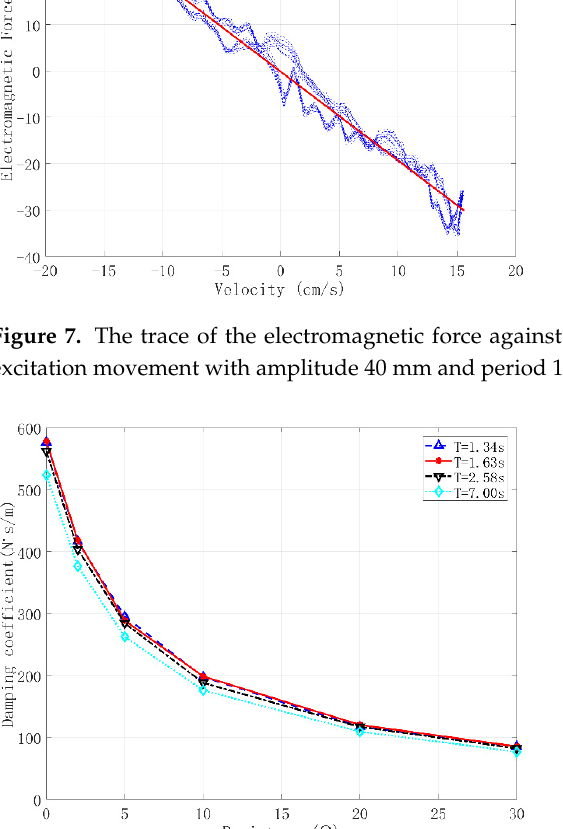
Figure 8. The equivalent damping coefficient provided by the motor’s electromagnetic force against the load resistance.